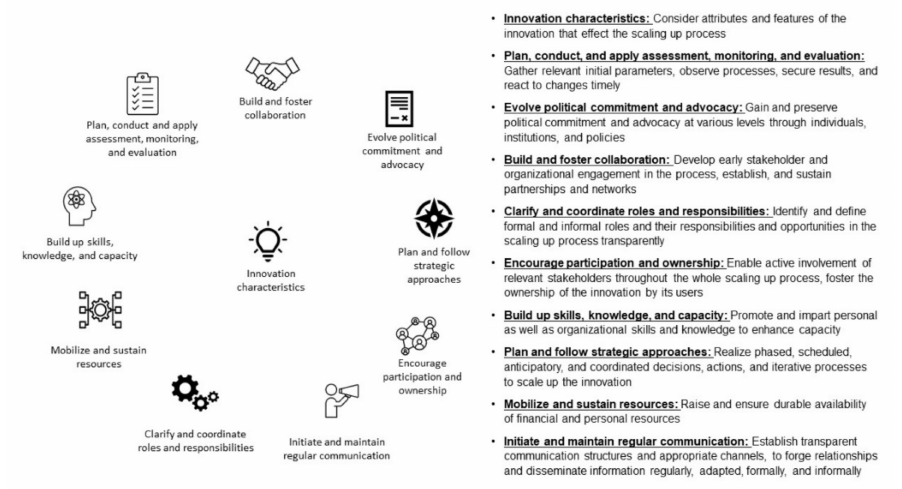
Figure 3. Scaling-up framework with key components for scaling up community-based health